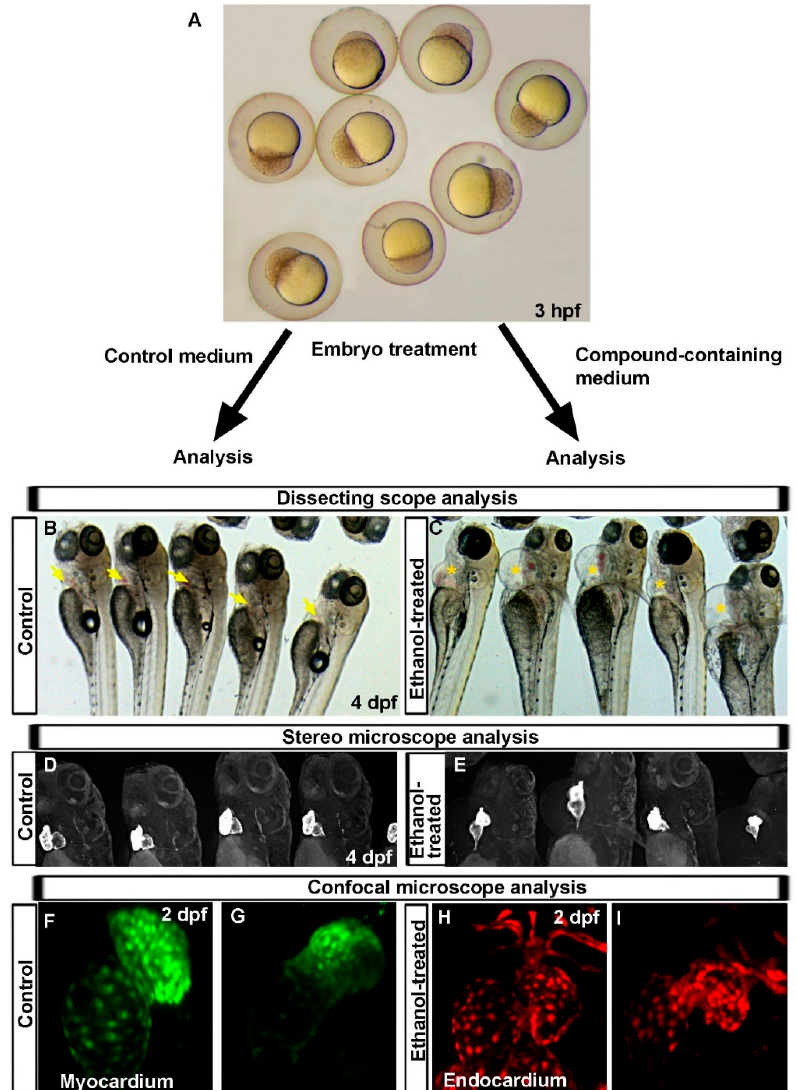
Figure 1. Advantages of use of zebrafish in cardiotoxicity research, which provide enormous information within a short time. ( A ) Dissecting microscope image of 3 hpf zebrafish embryos showing how easily accessible zebrafish embryos are to treat with chemicals at different developmental stages for desired periods; ( B , C ) Dissecting microscope images showing normal pericardium in the control embryos ( yellow arrow ) ( B ) and pericardial edema phenotype in 4 days post-fertilization (dpf) ethanol-treated zebrafish embryos ( yellow star ) to help predict defective cardiogenesis ( C ); ( D , E ) Bright field images of Tg ( myl7:GFP ) embryos showing normal shaped two-chambered heart in control ( D ) and an almost linear heart in ethanol-exposed embryos ( E ), confirming heart malformation after ethanol exposure; ( F , G ) Confocal images of Tg ( myl7:nlsKiKGR ) embryos showing nuclei of cardiomyocytes in closely apposed bean-shaped atrium and ventricle in control embryos ( F ), fewer cardiomyocytes are seen in misshapen chambers of ethanol-treated embryos ( G ); and ( H , I ) Confocal images of Tg ( fli1:EGFP ) embryos show endocardial cells in normal endocardium in control embryos ( H ), fewer endocardial cells are seen in misshapen endocardium of ethanol-treated embryo ( I ).